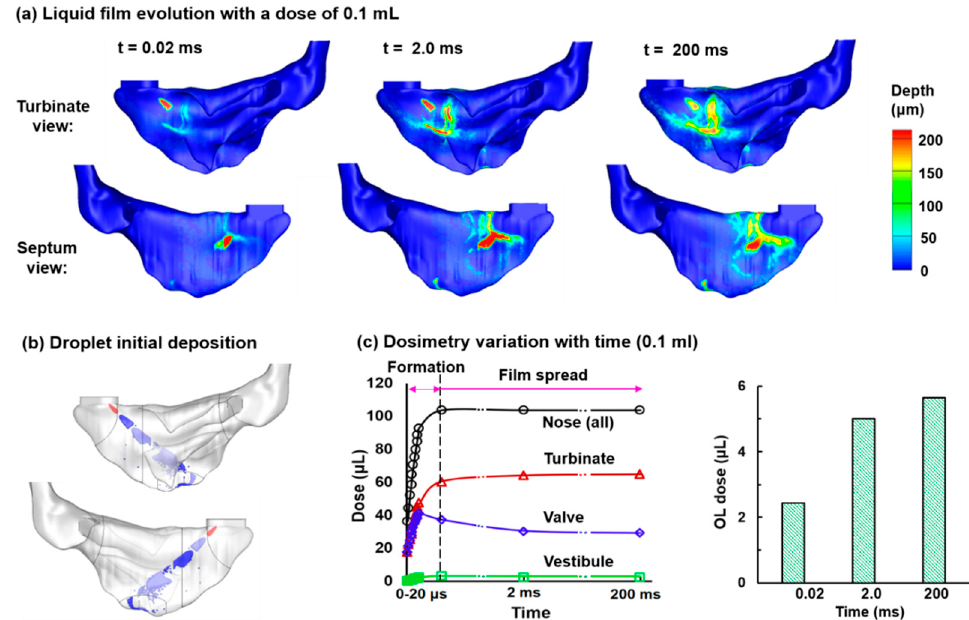
Figure 9. Nasal spray droplet deposition and wall film formation with the proposed delivery system: ( a ) liquid film temporal evolution with a dose of 0.1 mL; ( b ) initial droplet deposition distribution; ( c ) dose variation with time in the nose and OL.